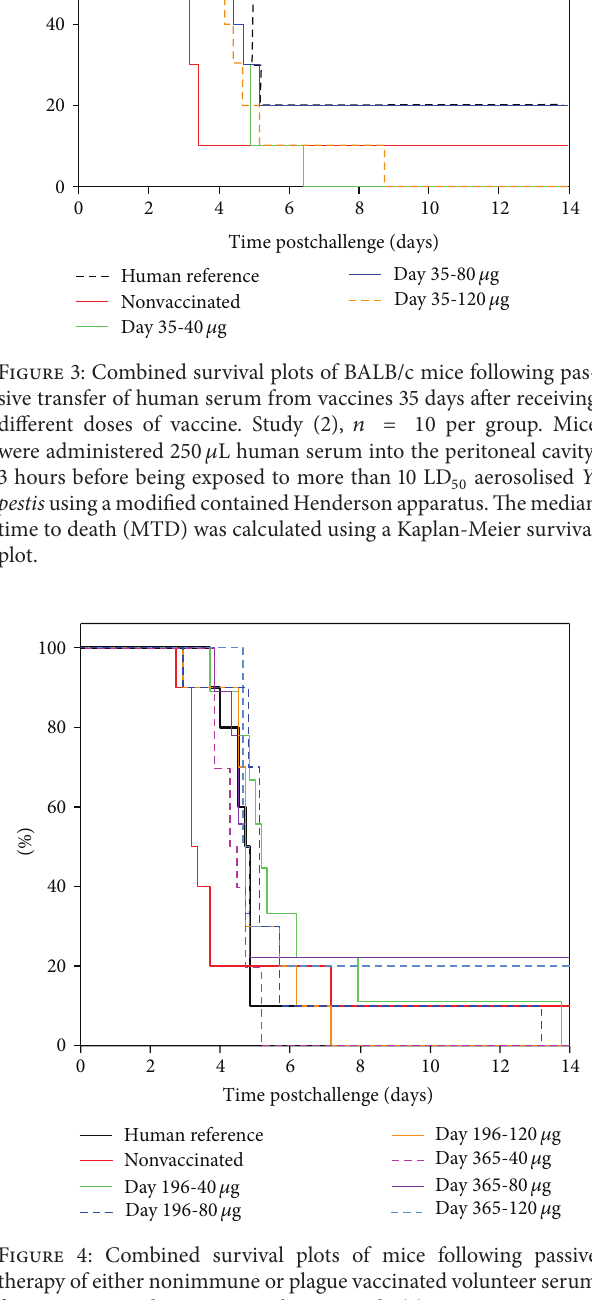
Figure 4: Combined survival plots of mice following passive therapy of either nonimmune or plague vaccinated volunteer serum from 196 to 365 days postinoculation. Study (3), 𝑛 = 10 per group. BALB/c mice were administered 250 𝜇 L human serum into the peritoneal cavity, 3 hours before being exposed to Y. pestis using a modifiedcontainedHendersonapparatus.Themediantimetodeath (MTD) was calculated using a Kaplan-Meier survival